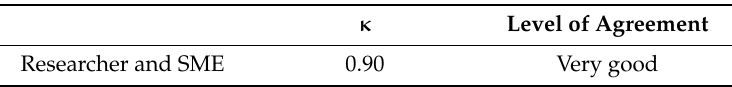
Table 4. Determined inter-rater concordance.